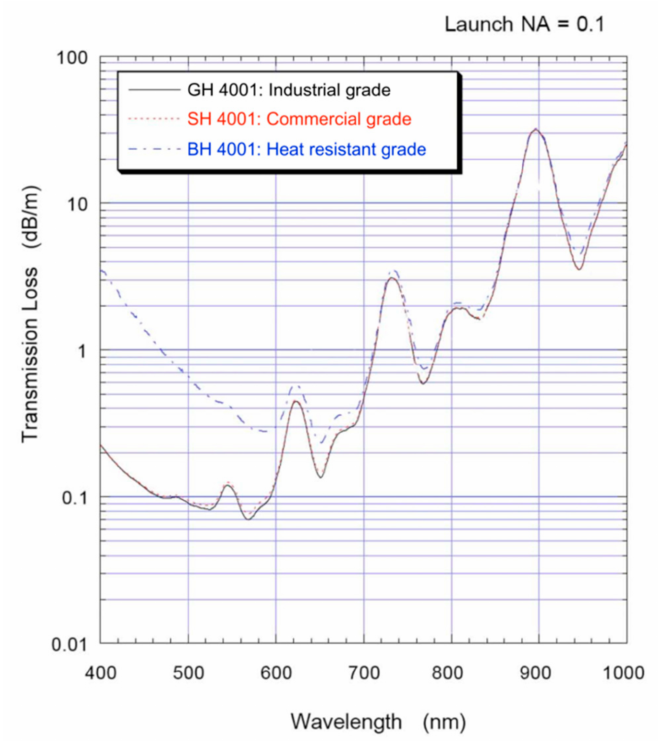
Figure 1. The typical transmission loss spectra of PMMA-based POFs from ESKA TM